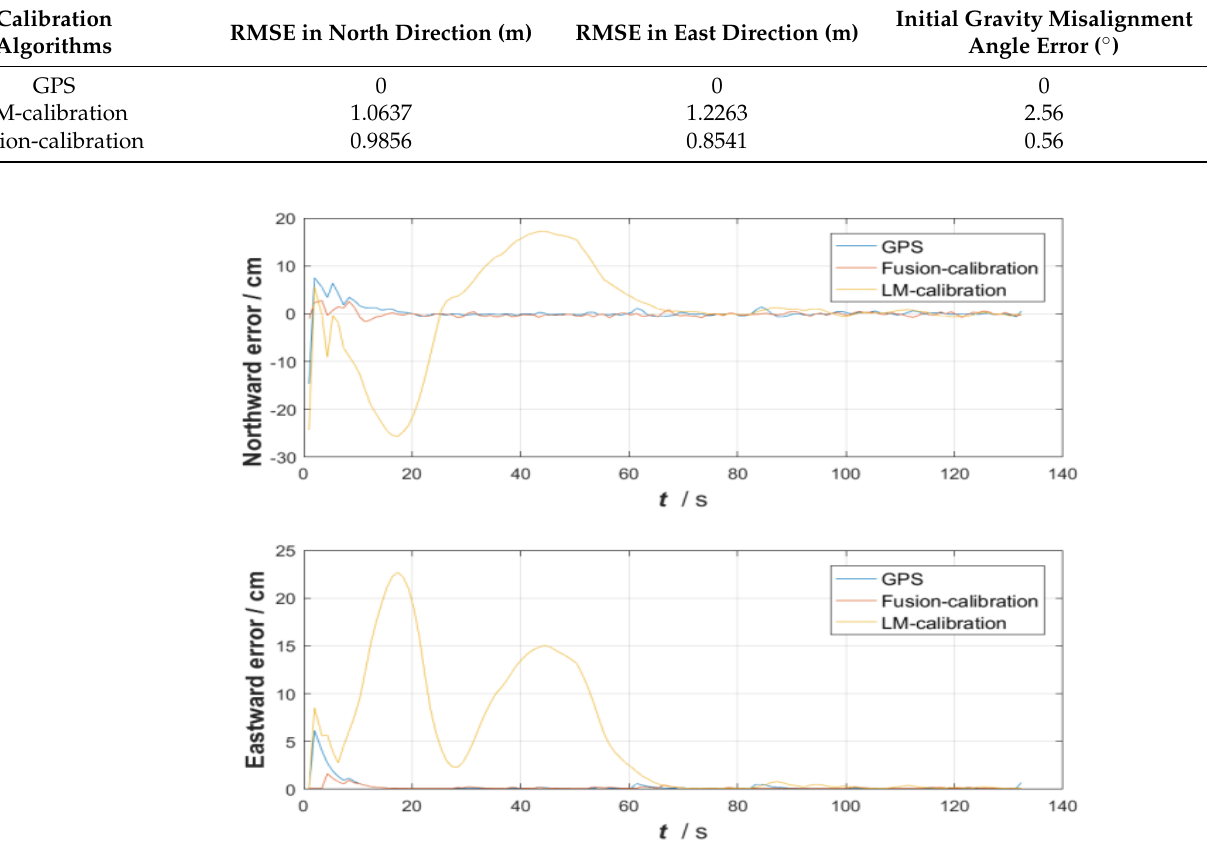
Figure 12. Vertical comparison error and horizontal comparison error. Table 11. Vertical comparison error and horizontal comparison error.